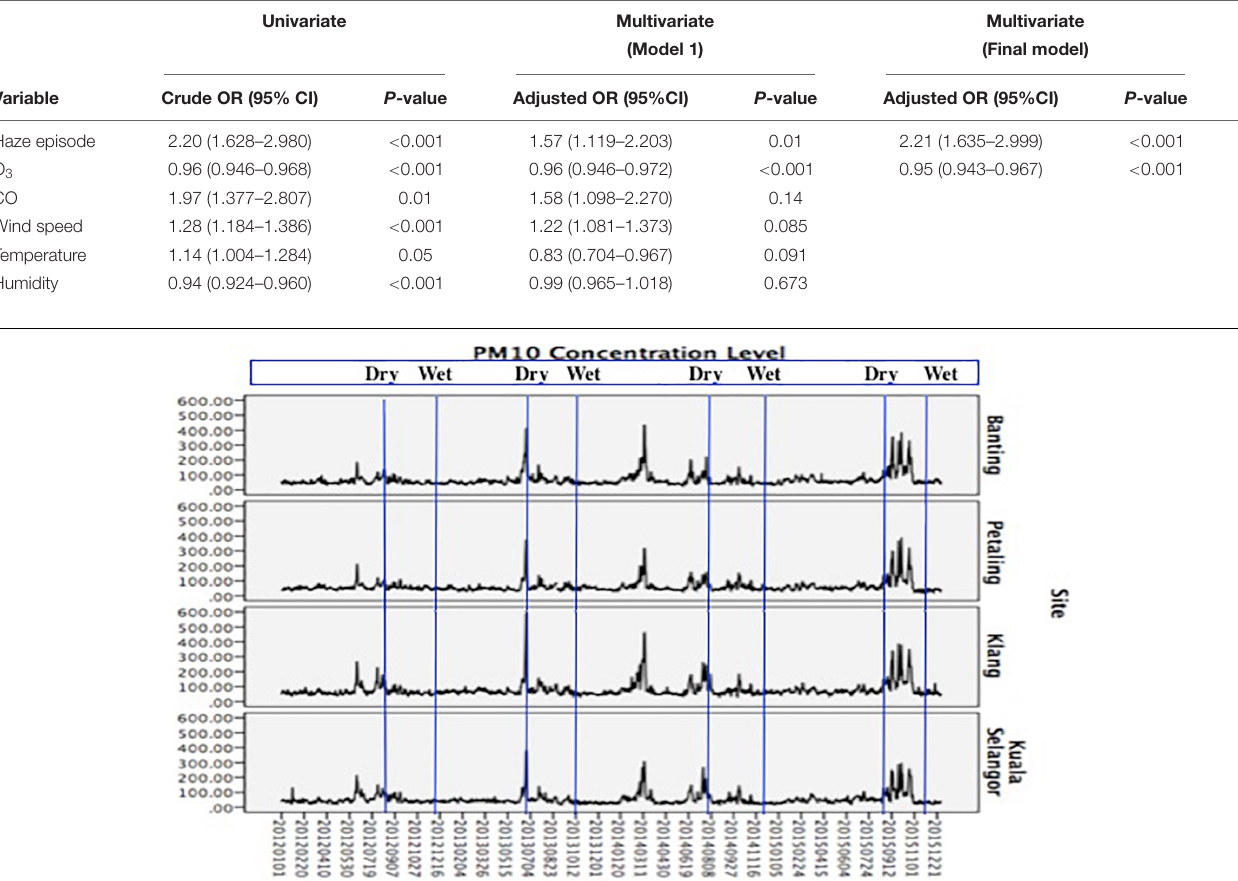
TABLE 6 | Crude and adjusted odds ratios in univariate and multivariate regression analyses (outpatient). Univariate Multivariate Multivariate